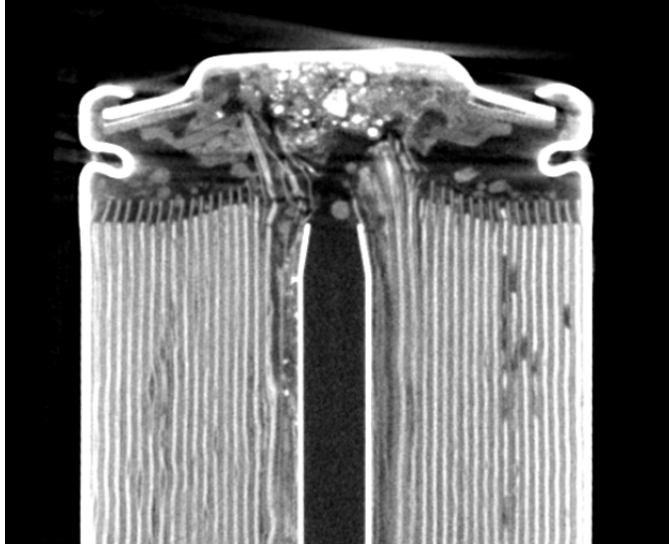
Figure 7. CT scan of the defective cell (1p4). All security mechanisms in the upper part of the cell were destroyed. The cell winding shows a multitude of